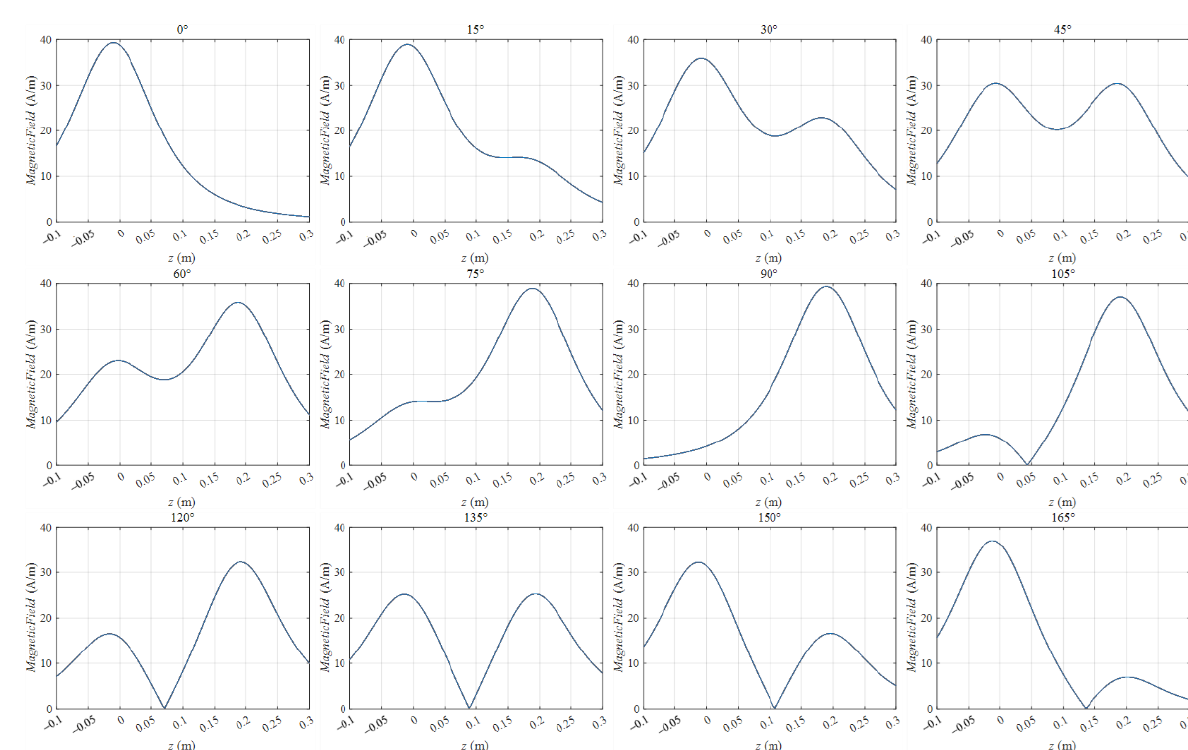
Figure 3. Component distributions varying from 0° to 180° in 15° intervals.